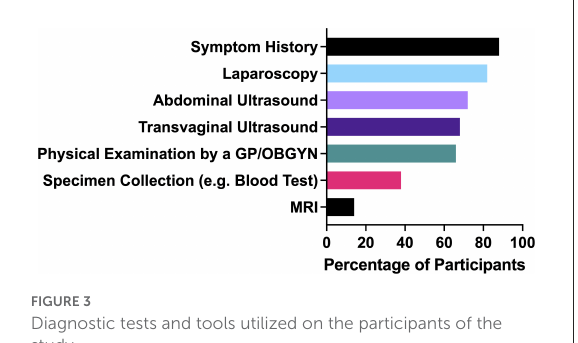
FIGURE3 Diagnostic tests and tools utilized on the participants of the study.